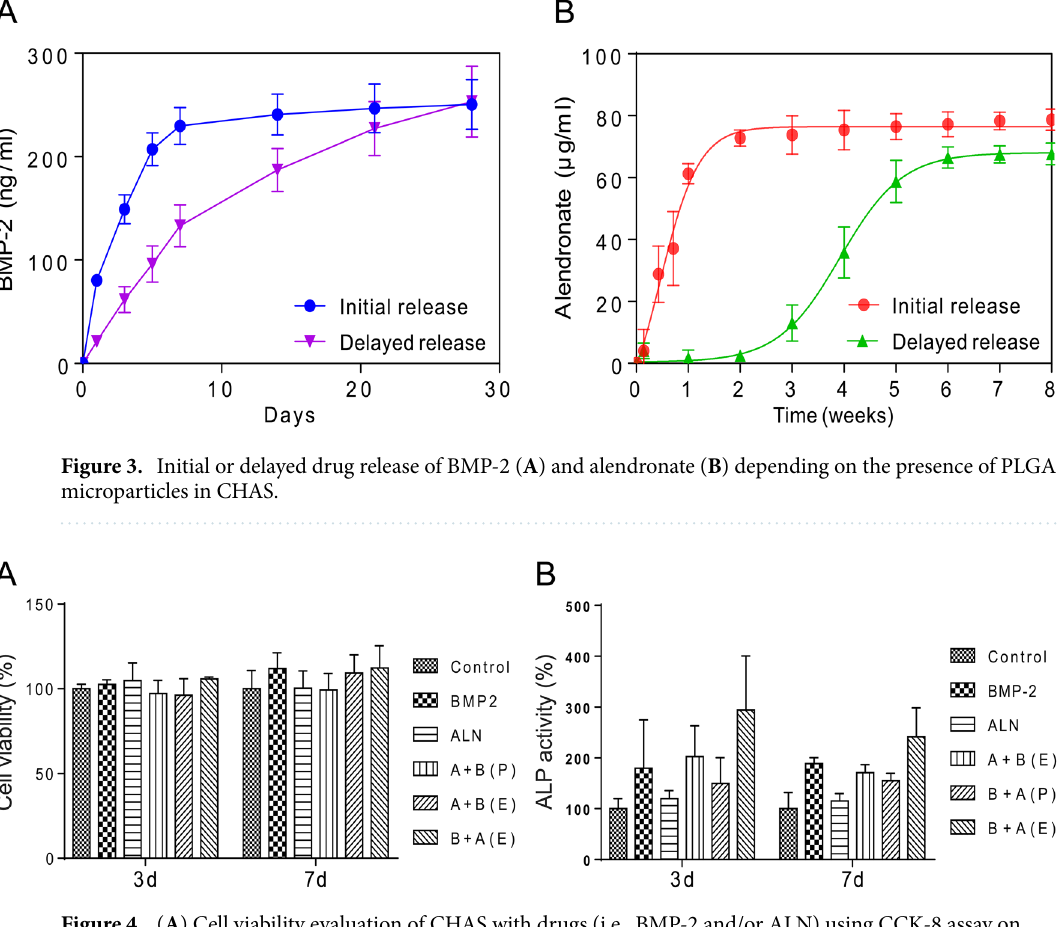
Figure 4. ( A ) Cell viability evaluation of CHAS with drugs (i.e., BMP-2 and/or ALN) using CCK-8 assay on osteoblasts. ( B ) ALP activity of osteoblasts in CHAS depending on the drugs (i.e., BMP-2 and/or